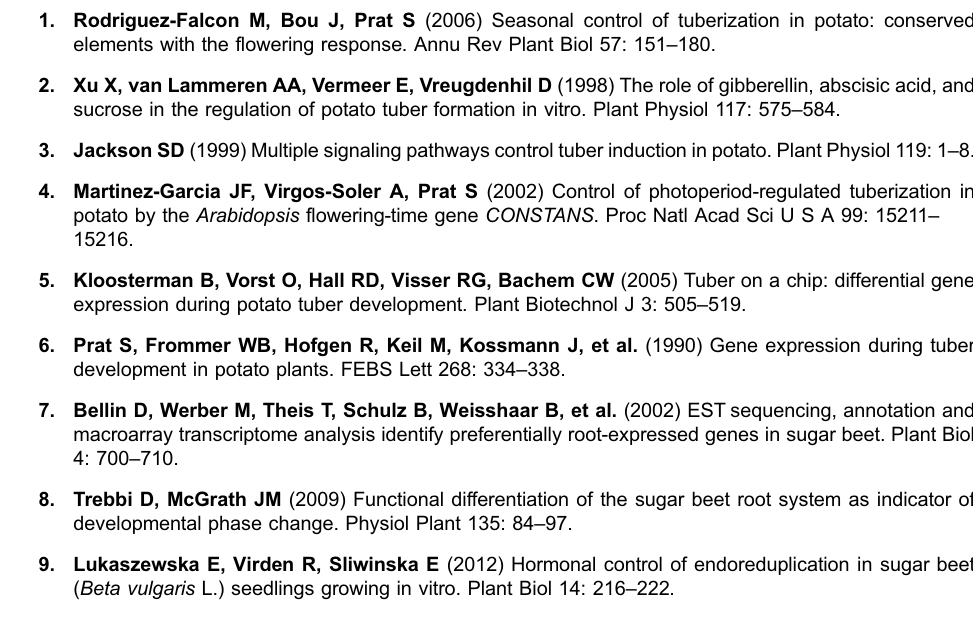
Table S9. Descriptive of phenotypic variation between Asian and European subpopulations with and without vernalization for each trait from five independent experiments. Within the same trait, same accession, the values accompanied by the common letter show no significant difference between the treatments. The presented traits are flowering time (FT), tuber weight (Twe), tuber width (Twi), tuber shoots number (Tsh) tuber growing depth (Tgd), tuber swelling onset (Tso), tuber surface smoothness (Tss), tuber color (TC), leaf and stem weight (Lwe), leaf length (LL), lamina blade width (LBW), leaf index (LI), leaf color (LC), petiole width (PW), leaf blade shape outline (LS), leaf lamina attitude (LAT) and leaf edge shape